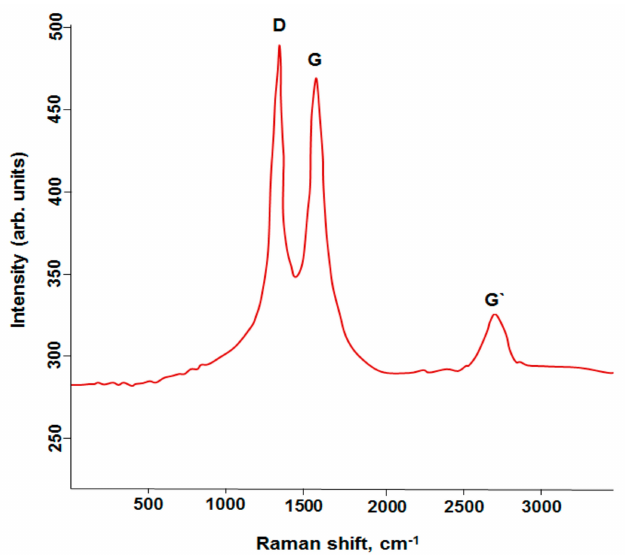
Figure 1. Raman spectrum of a MWCNT sample.